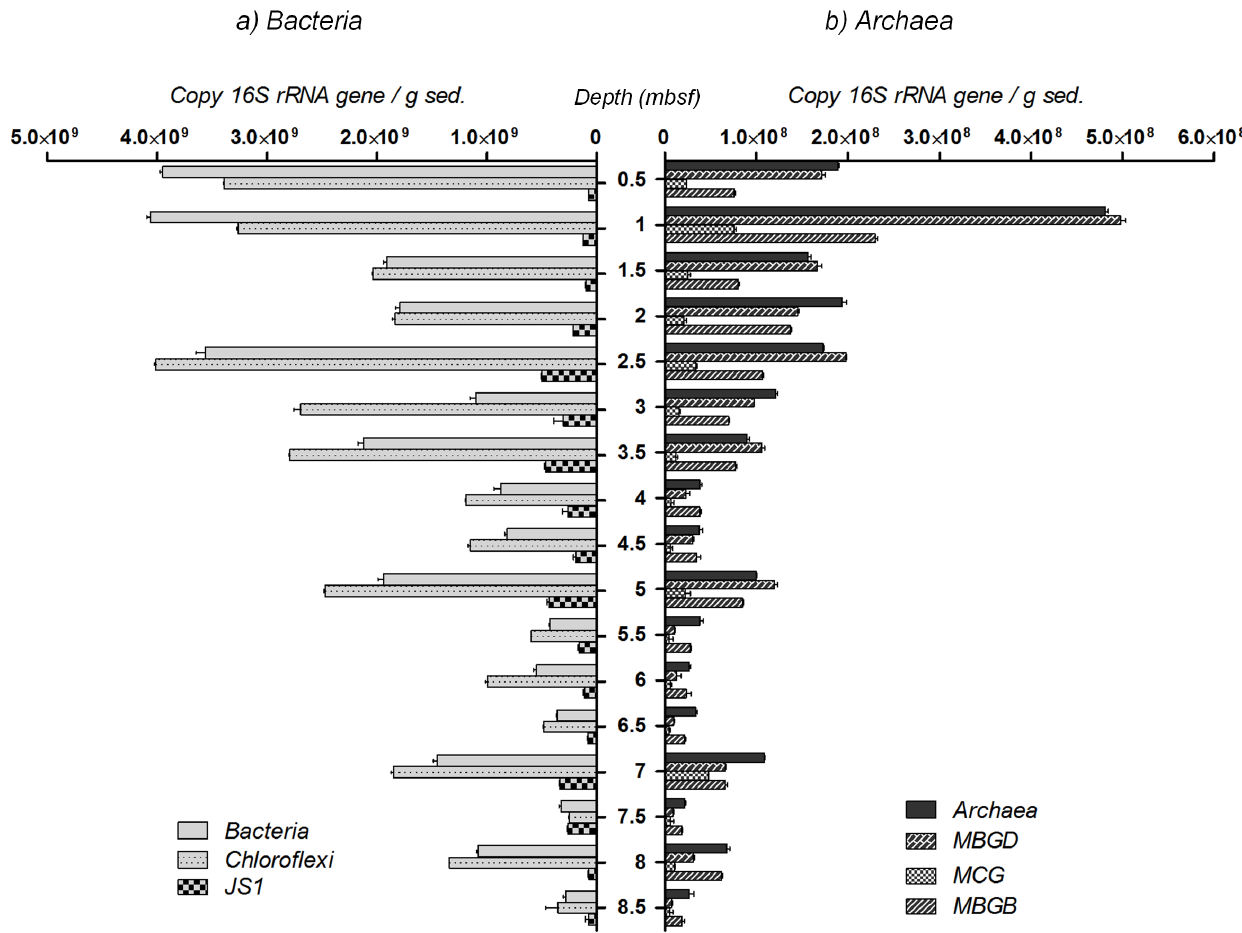
Figure 3. Q-PCR estimations. Q-PCR estimation of 16S rRNA gene copy numbers per gram of sediment for a) total Bacteria and bacterial groups of Chloroflexi , candidate division JS1 and b) total Archaea and archaeal groups of Marine Benthic Group B (MBGB), D (MBGD), Miscellaneous Crenarchaeotal Group (MCG), from BCK1 sediment core. Methanosarcinales were only detected at 1 mbsf with 2.4 6 10 6 16S rRNA gene copies g 2 1 but were not represented in the figure. ANaerobic MEthanotrophs (ANME), Desulfosarcina / Desulfococcus (DSS), Desulfobulbus (DBB) and other methanogens orders were not detected in analyzed samples.